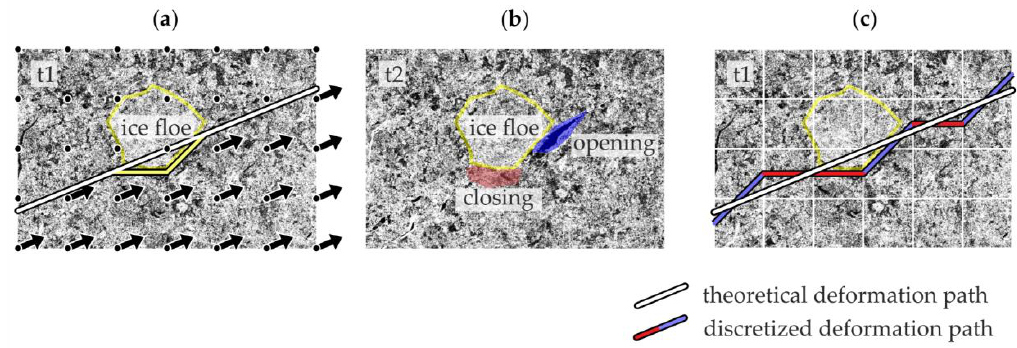
Figure 10. Sentinel-1 image acquired over Arctic sea ice showing an example of a small ice floe locally changing the path of the discontinuity ( a ). The calculated opening and closing are real, which can be recognized at the margin of the ice floe ( b ). The discrete deformation path at the location of the floe is closer to reality than the theoretical path ( c ).